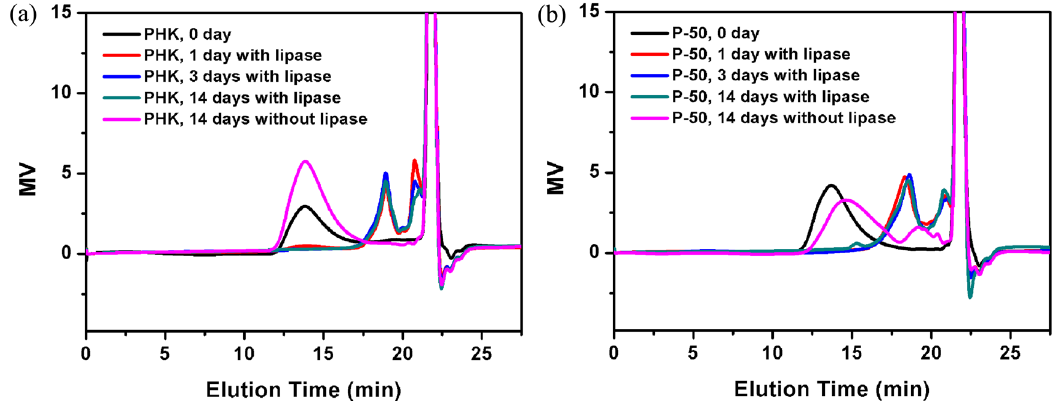
Figure 6: GPC curves of the products for the PHK homopolymer ( a ) and the P - 50 copolymer ( b ) degraded with CALB ( 0.1% w/v )